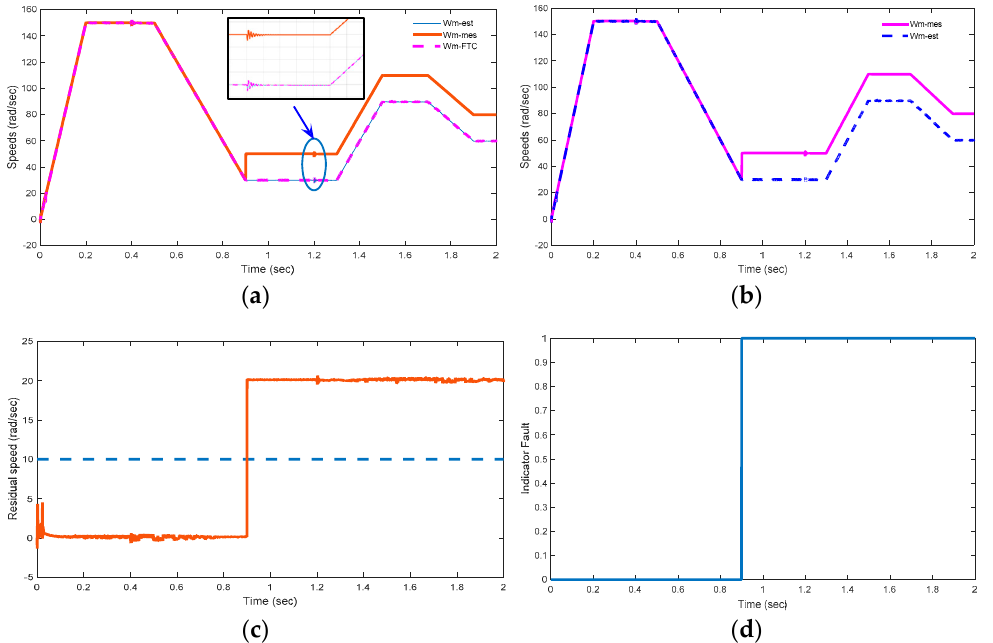
Figure 8. 5P-PMSM performance with speed sensor constant fault: ( a ) speed dynamics with load torque application; ( b ) measured and estimated speeds with FTC; ( c ) residual speed signal and threshold; ( d ) fault